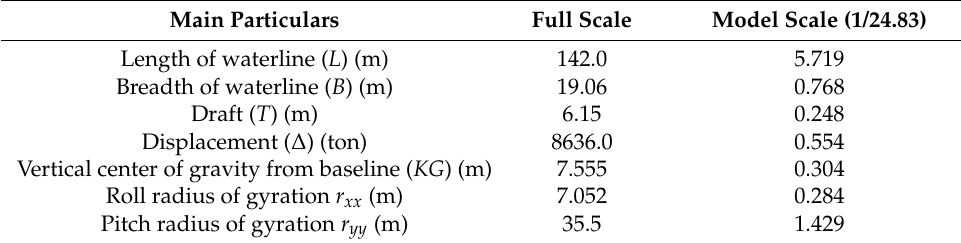
Table 1. Main particulars of